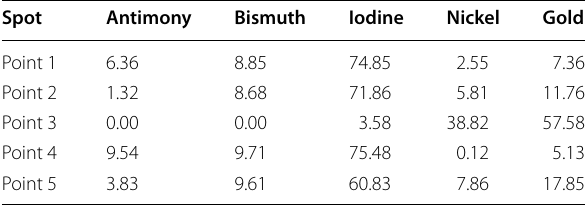
Table 6 Elemental distribution (atomic %) of the